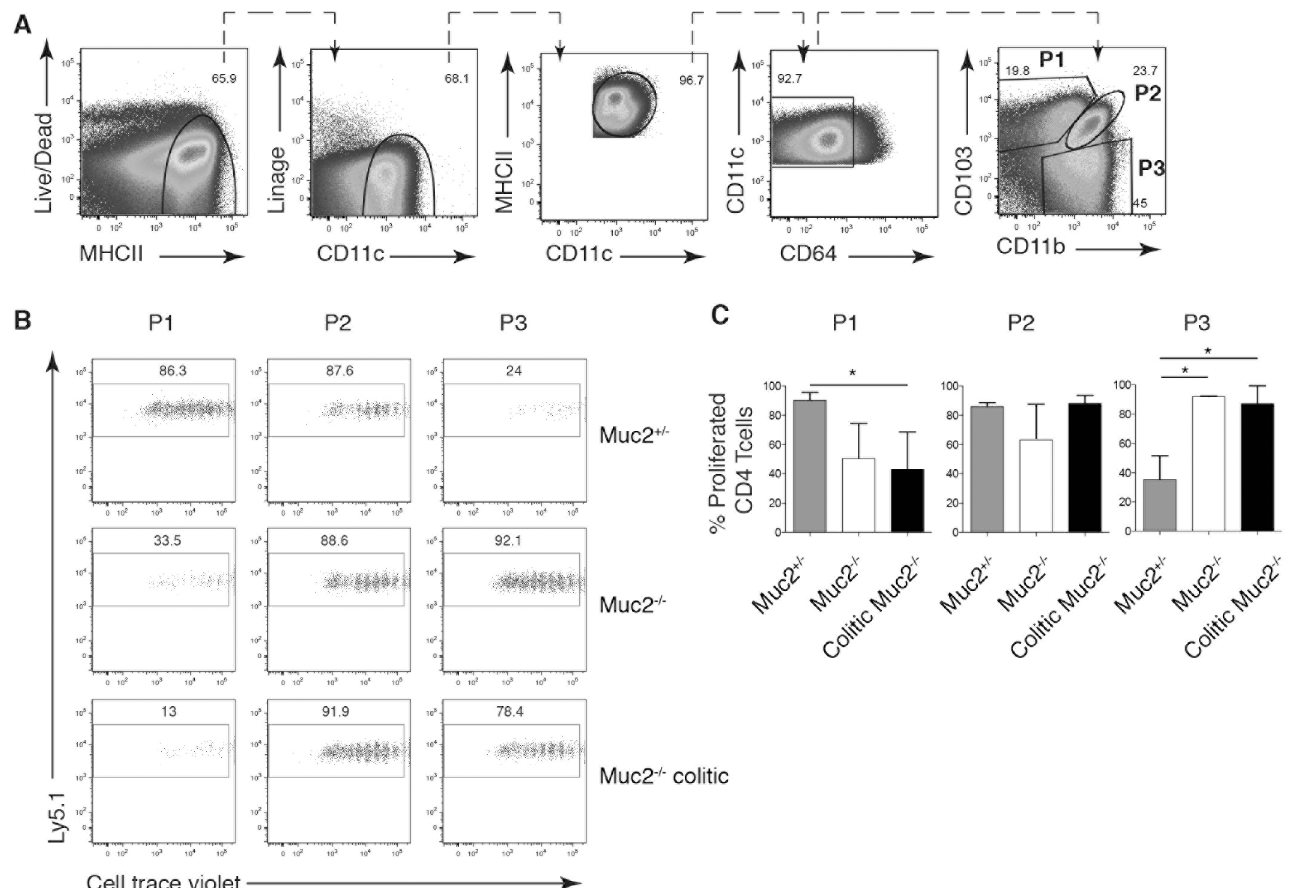
Fig 5. Colitis influences the ability of intestinal DC subsets to induce CD4 + T cell proliferation. P1, P2 and P3 cells were sorted from pooled MLN from Muc2 +/- , Muc2 -/- or colitic Muc2 -/- and analyzed by flow cytometry. Sorted cells were pulsed with OVA (323 – 339) peptide prior to co-incubation with CTV-labeled OT-II cells for 5 days. (A) The gating strategy used to identify P1, P2, and P3 populations from MLN cell suspensions is shown. (B) Dot plots show CTV dilution of OT-II cells co-cultured with the indicated iMP subset pulsed with OVA (323 – 339) peptide. (C) Bar graphs show the frequency of proliferating OT-II T cells ± SD from